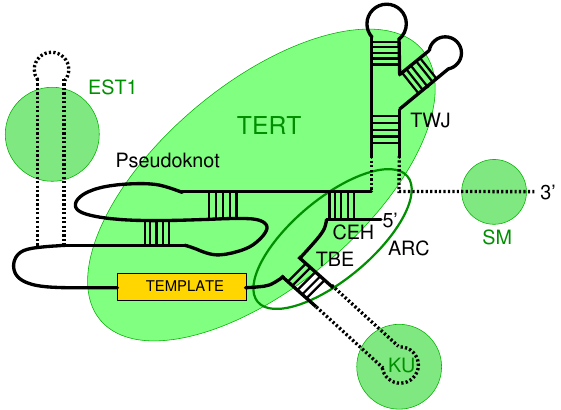
Figure 1. Schematic organization of telomerase RNA (TER). Contact regions for important binding sites are indicated by green circles (EST1, SM, and KU). The green ellipse denotes the contact region with the reverse transcriptase (TERT). Other major features are the template, the pseudoknot region, the template boundary element (TBE), the three-way junction (TWJ), and the Area of Required Connectivity (ARC). Adapted from